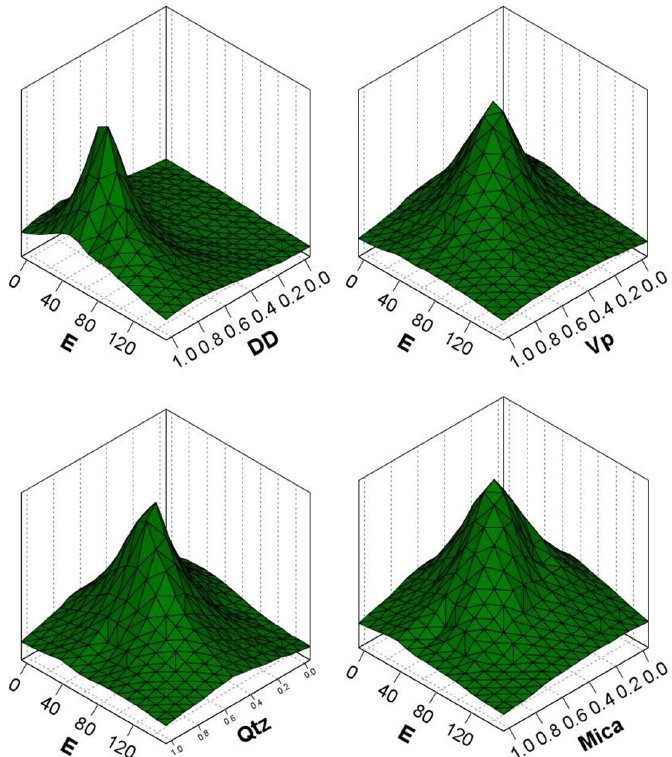
Figure 4. 3D density diagrams of pairs of each input variable and E.